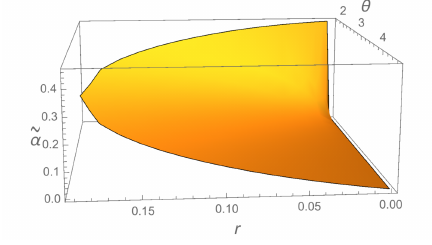
Figure 12. Plot of